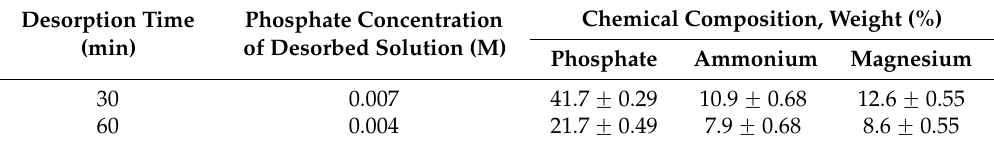
Table 2. Chemical composition of the recovered struvite precipitate (mean ˘ standard error).